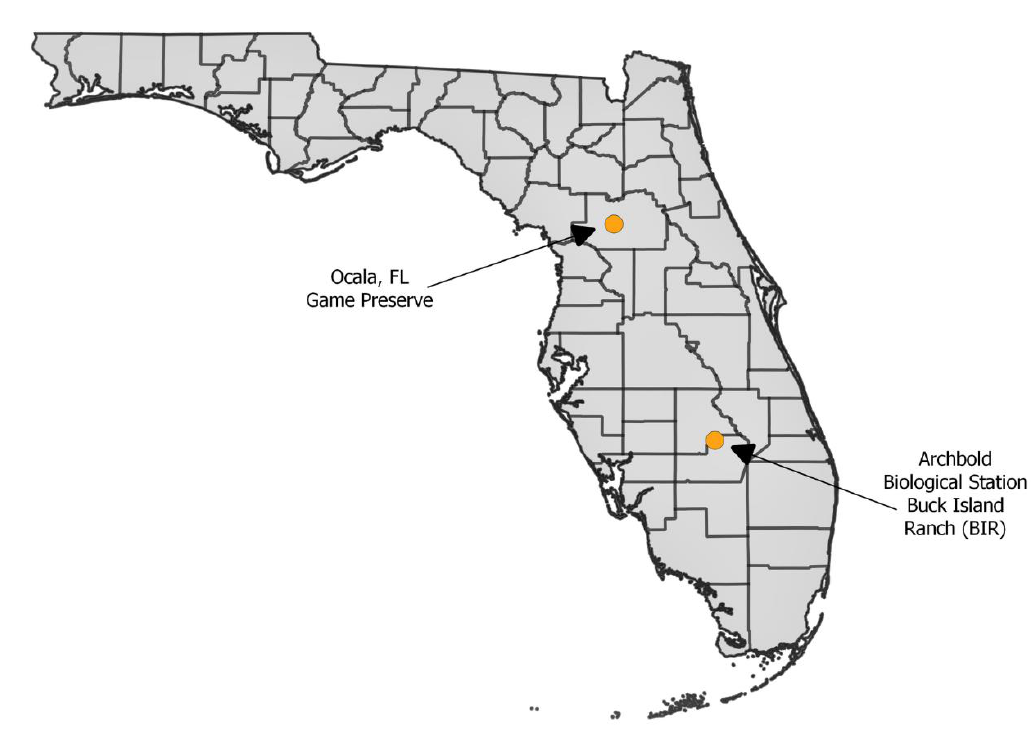
Figure 1. Location of the two field sites in Florida from where Culicoides insignis midges were collected. Map generated using QGIS3 and shapefiles from the Florida Geographic Data Library database.